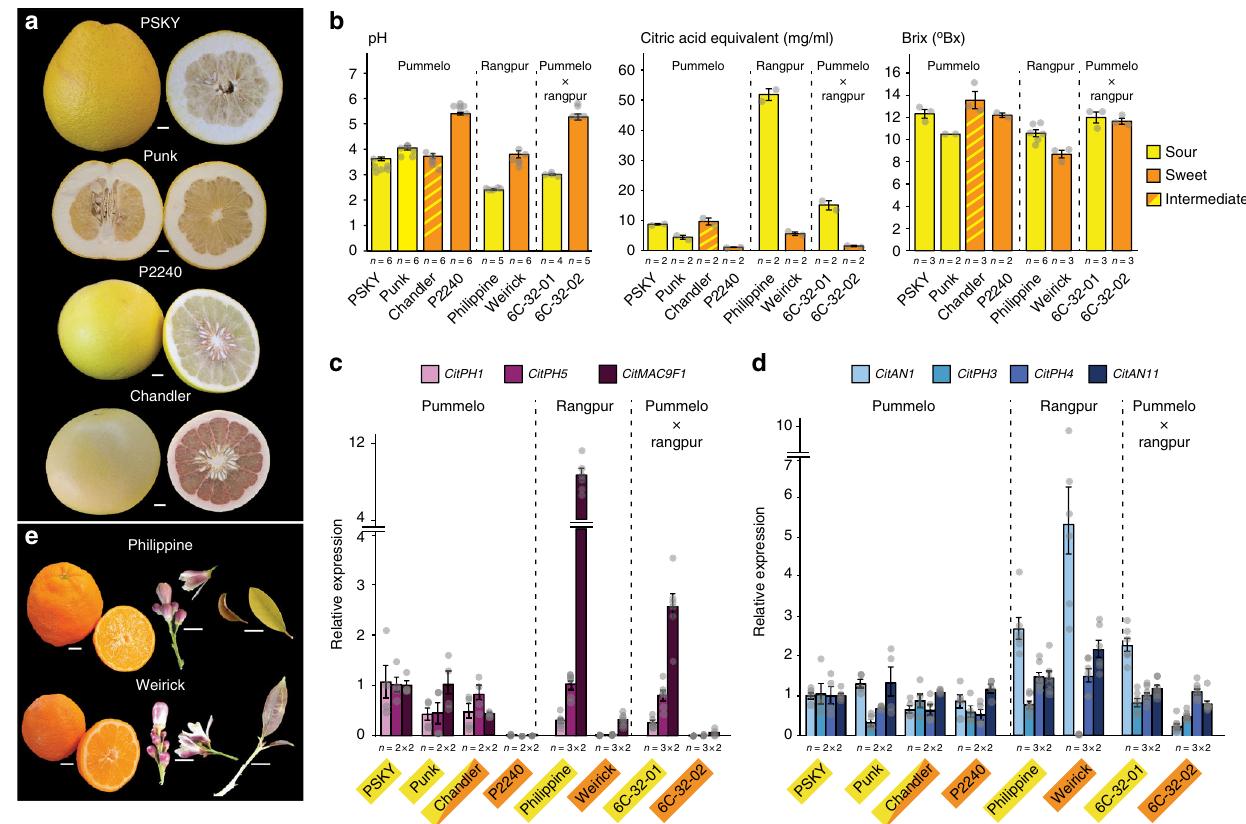
Fig. 6 Analysis of sweet and sour pummelo and rangpur lime varieties. a Fruits of the analyzed pummelo varieties. Size bars represent 1 cm. b pH, titratable acid, and soluble solid content (Brix) in juice from the analyzed varieties (mean ± SE). c Real-time RT-PCR of CitPH1 , CitPH5 , and CitMAC9F1 mRNA in juice vesicles. d Real-time RT-PCR of CitAN1 , CitPH3 , CitPH4 , and CitAN11 mRNA in juice vesicles. e Fruits, fl ower, and leaf phenotypes of the analyzed rangpur limes. Size bars represent 1 cm. Values in c , d are mean ± SE; n = number samples from different fruits × number of technical replicates of each. Fruits analyzed in b – d were mature with a slight green blush (pummelos) or full colored mature (rangpurs and rangpur × pummelo hybrids). Images of Punk and ‘ Chandler ’ fruits were provided by and reproduced with permission of the UC-Riverside Citrus Variety collection. Source data are provided as a Source Data fi